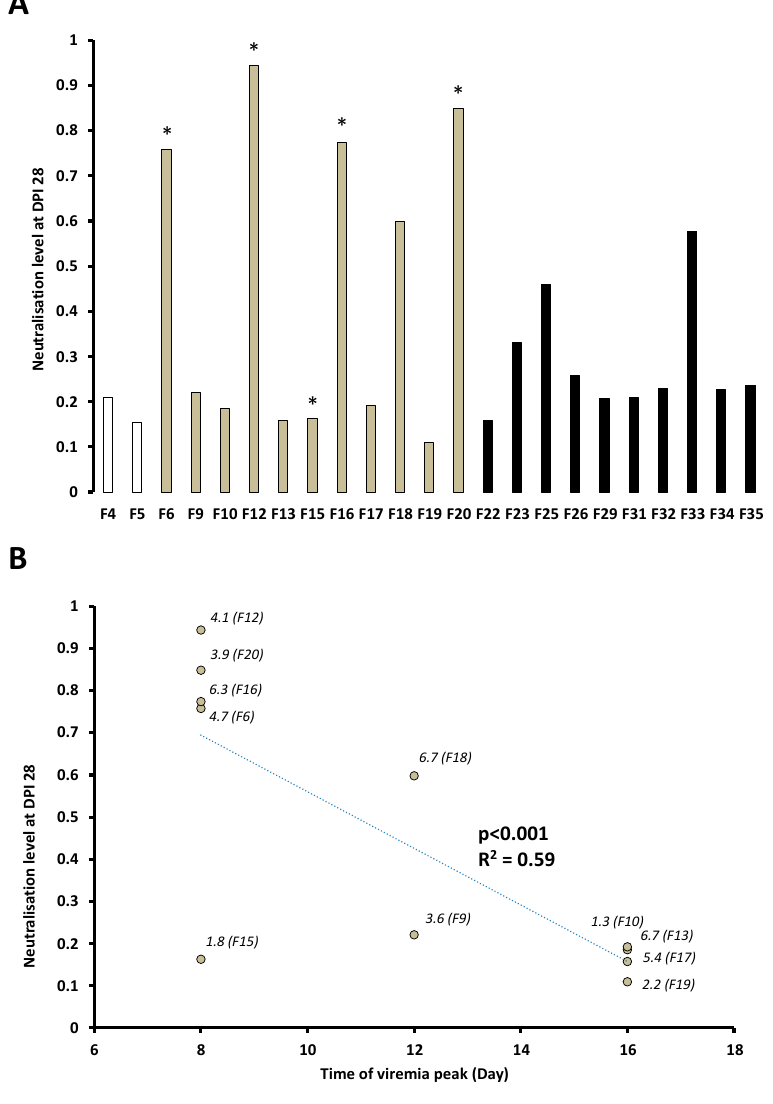
Figure 7. Neutralising activity of the plasma collected at 28 days post-infection (DPI). ( A ) Neutral- ising antibody levels are indicatedfor. groups: PBS-injected-uninfected group (F4-5, white), 3.1H- injected-infected group (F6-20, grey) and ppG-injected-infected group (F22-35, black). *: animal displaying early peak in viremia ( B ) Correlation between the level of neutralisation at dpi 28